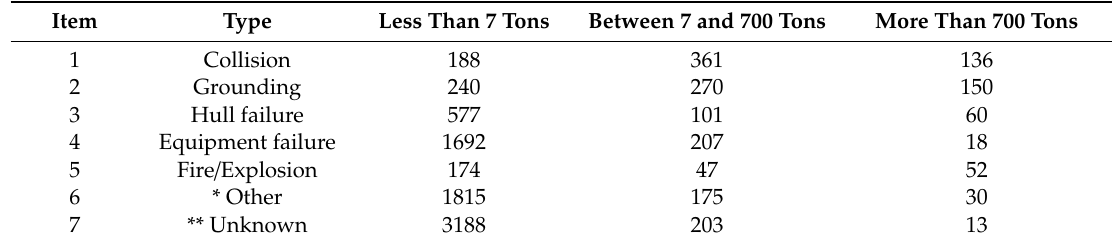
Table 2. Statistics on major oil spills from 1974 to